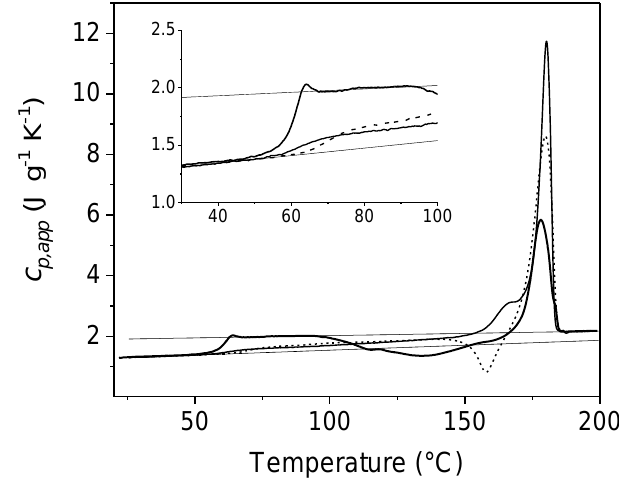
Figure 7. Apparent specific heat capacity ( c p,app ) of an amorphous PLLA sample (thickest solid line) and after complete isothermal crystallization at T c = 85 °C (dotted line) and T c = 145 °C (solid line) (heating rate 10 K min −1 ). The thin solid lines are the solid and liquid thermodynamic specific heat capacities, as taken from the literature [45]. The inset is an enlargement of the T g region. (Reprinted (adapted) with permission from [46]. Copyright (2015) Elsevier).